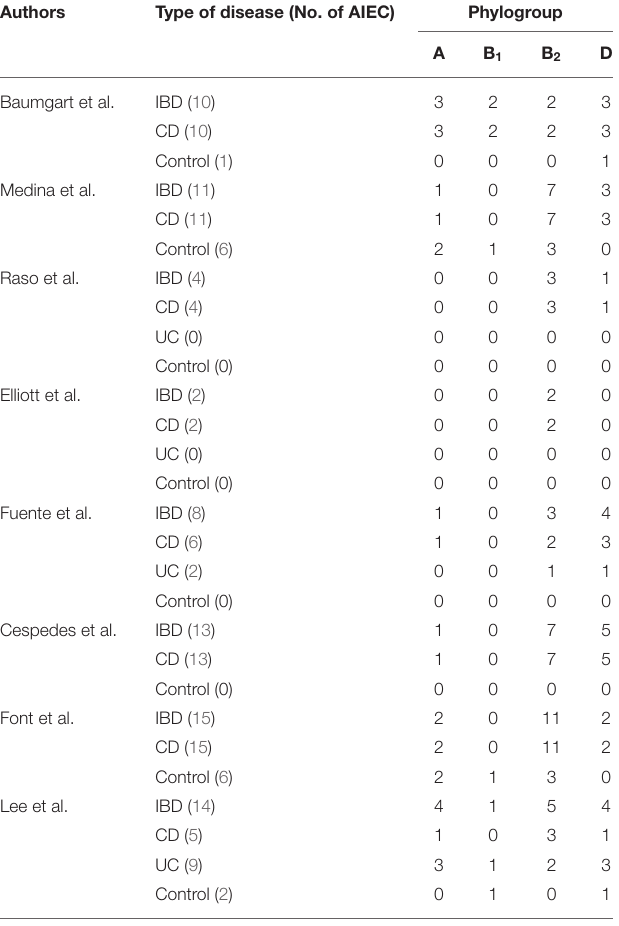
TABLE 3 | Phylogroups distribution among AIEC